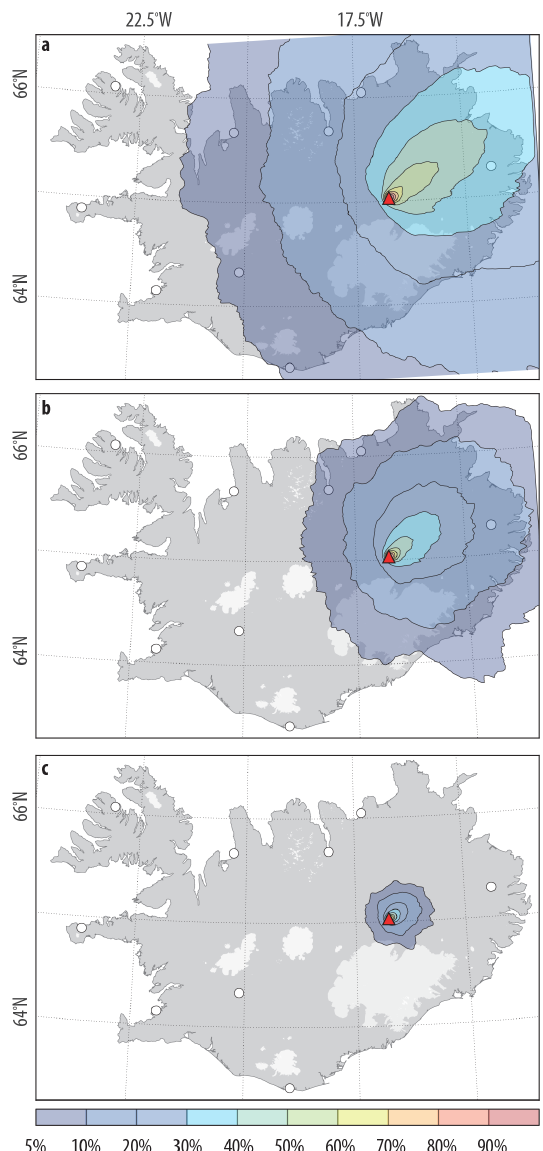
Figure 11. Probability maps (%) for ground accumulation asso- ciated with a multi-phase 1875-type eruption at Askja volcano. (a) OES, threshold of 1kgm − 2 ; (b) OES, threshold of 10kgm − 2 ; (c) OES, threshold of 100kgm − 2 . Eruption parameters are summa- rized in Table 3 and Fig.